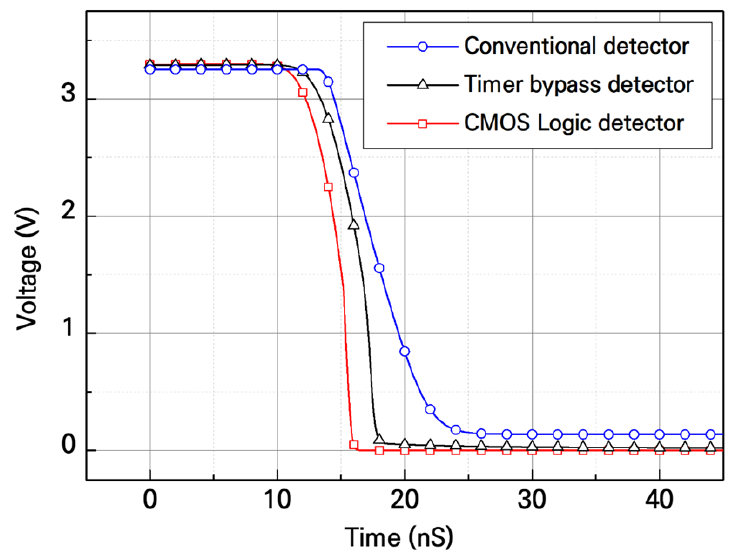
Figure 7. Response time simulation result of the pulsed-radiation detection circuit.